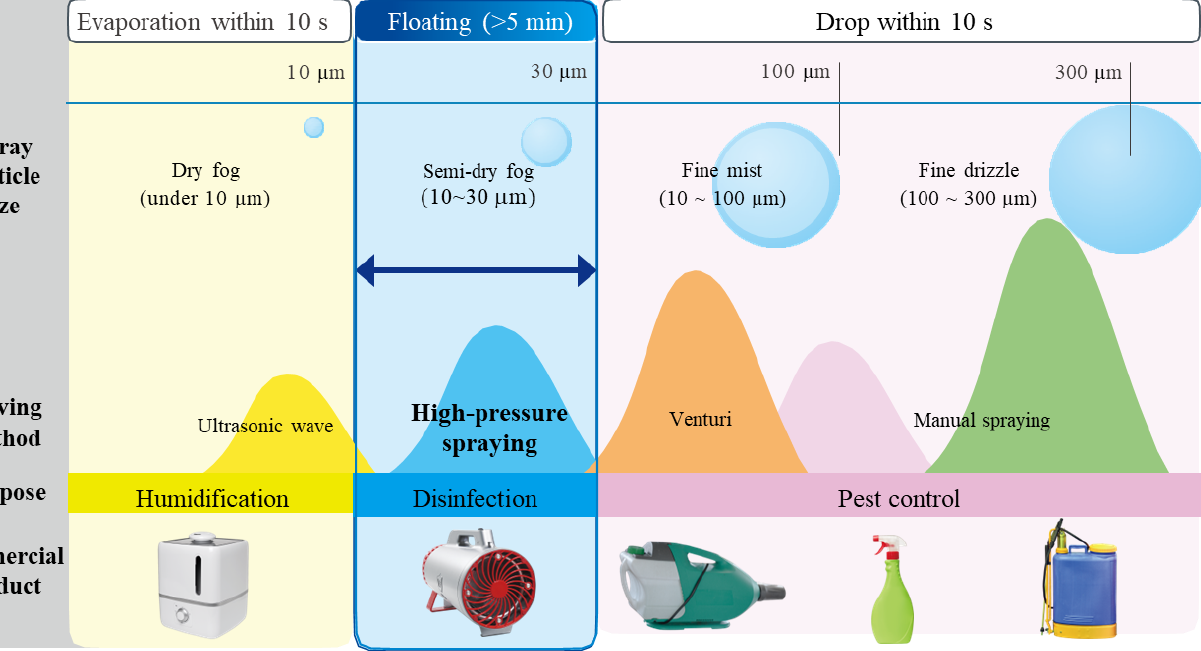
Figure 3. Size distribution of droplets generated by various sprayers. Various commercial products used in humidification, disinfection, and pest control were used to compare the particle sizes of spray at different stages at specific times. Various products apply specific driving methods such as ultrasonic wave, high-pressure spraying, and venturi/manual spraying utilized for purposes such as humidification, disinfection, and pest control, respectively. The machine analyzer from Malvern Panalytical Ltd. was utilized to determine the specific spray particle size. Sizes of particles were measured in 3 stages: Stage 1: evaporation within 10 s; Stage 2: floating for about 5 s; Stage 3: drop within 10 s. Particle sizes are classified into four, namely, dry fog (<10 μ m), semi-dry fog (10 – 30 μ m), fine mist (10 – 100 μ m), and fine drizzle (100 – 300 μ m). Results showed that over 90% of the detected particle sizes ranged from 10 to 30 μ m which is the effective range of spray particle size when NEW generated by the ViKiller ® (TracoWorld Ltd.) was used for disinfection.